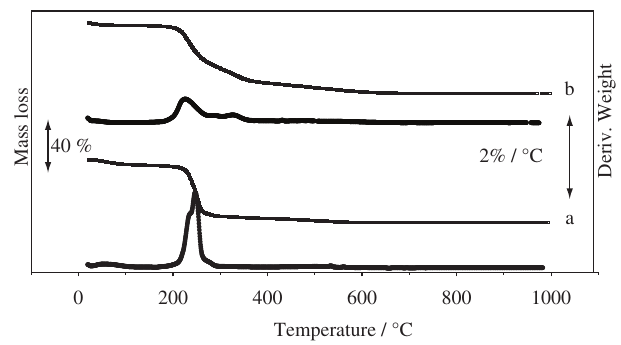
Figure 2. Termogravimetric curves: a) sol-gel and b) sol-gel functionalised with 15% of MPTMS.